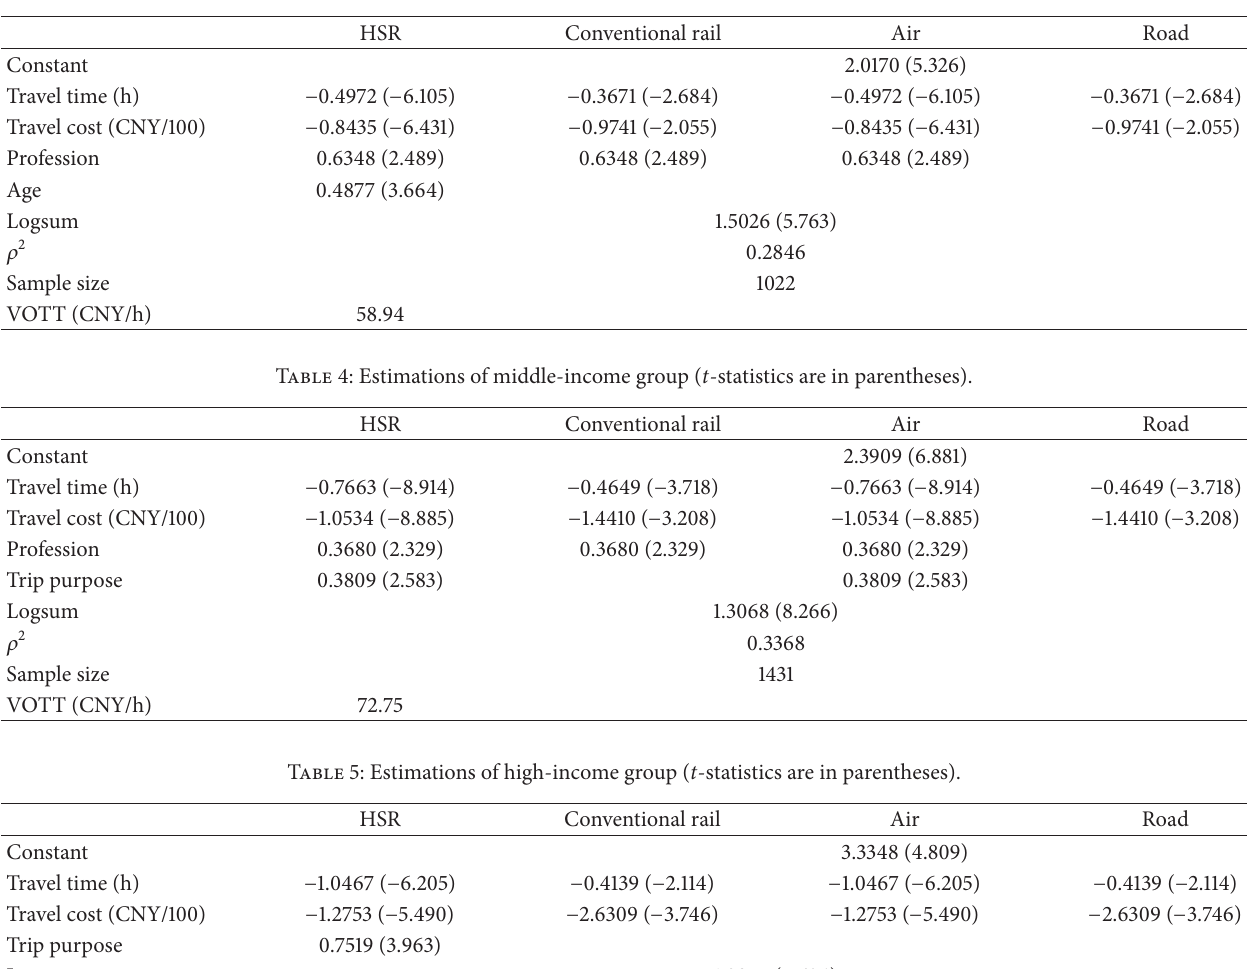
Table 3: Estimations of low-income group ( t -statistics are in parentheses).